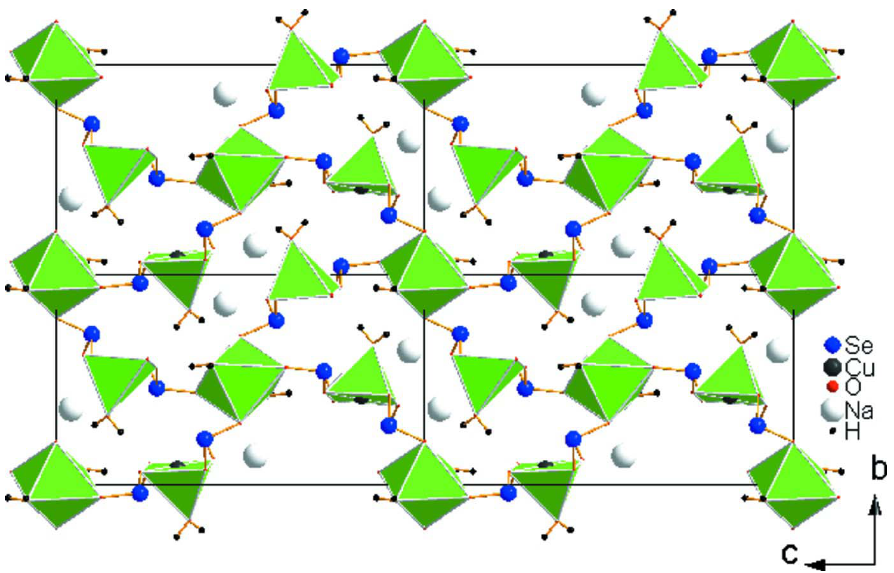
The coordination environment of copper and selenium atoms with anisotropic thermal ellipsoids drawn at the 60% probability level. H atoms are draw as small spheres of arbitrary radius. [Symmetry codes: (i) - x , - y , - z ; (ii) - x - 1, y - 1/2, - z + 1/2; (iii) x + 1, y , z ; (iv) x - 1, y , z